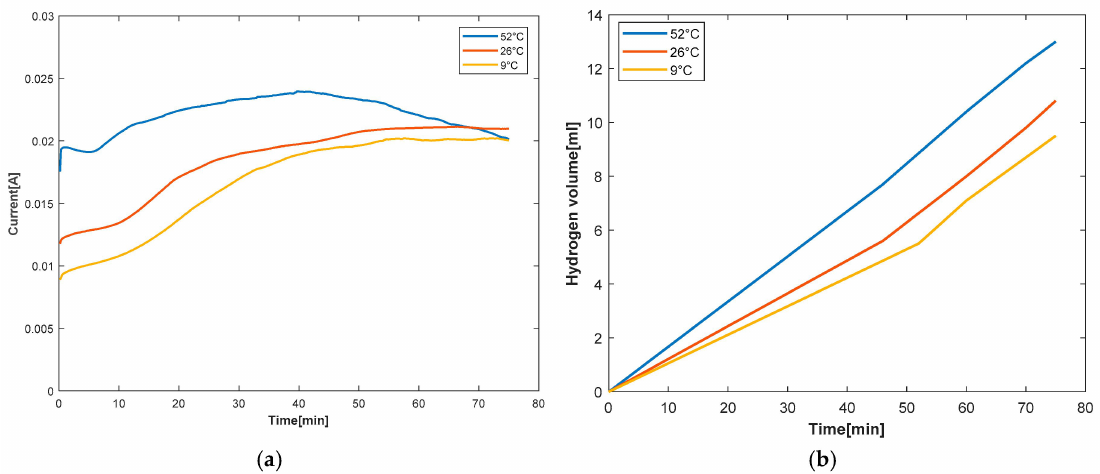
Figure 9. Experimental results according to initial temperature of electrolyte ( a ) Current ( b ) Hydrogen